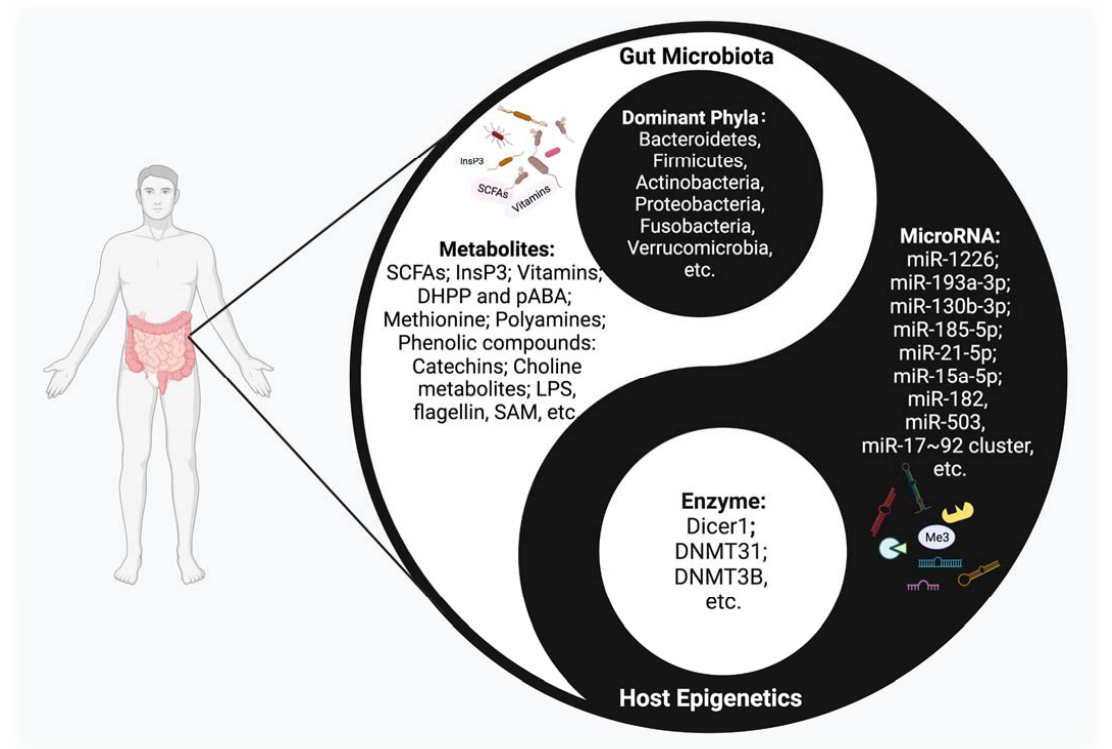
Figure 1. The Interplay between host epigenetic mechanisms and gut microbiota. Gut microbiota inhabit the intestinal tract and are in symbiosis harmoniously with the human body, constituting a microecology in a yin-yang dynamic balance. Once this balance is disrupted, various diseases may occur. The host regulates the diversity and composition of gut microbiota through miRNAs and other epigenetic factors. Intestinal flora, along with their metabolites, could regulate multiple epigenetic pathways; e.g., DNA methylation, miRNA, or histone modification in the host.